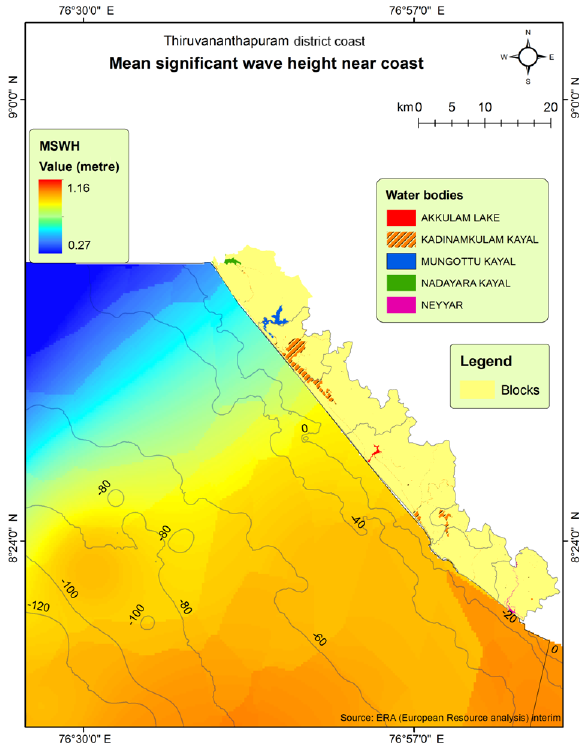
Figure 2. Mean significant wave height along the